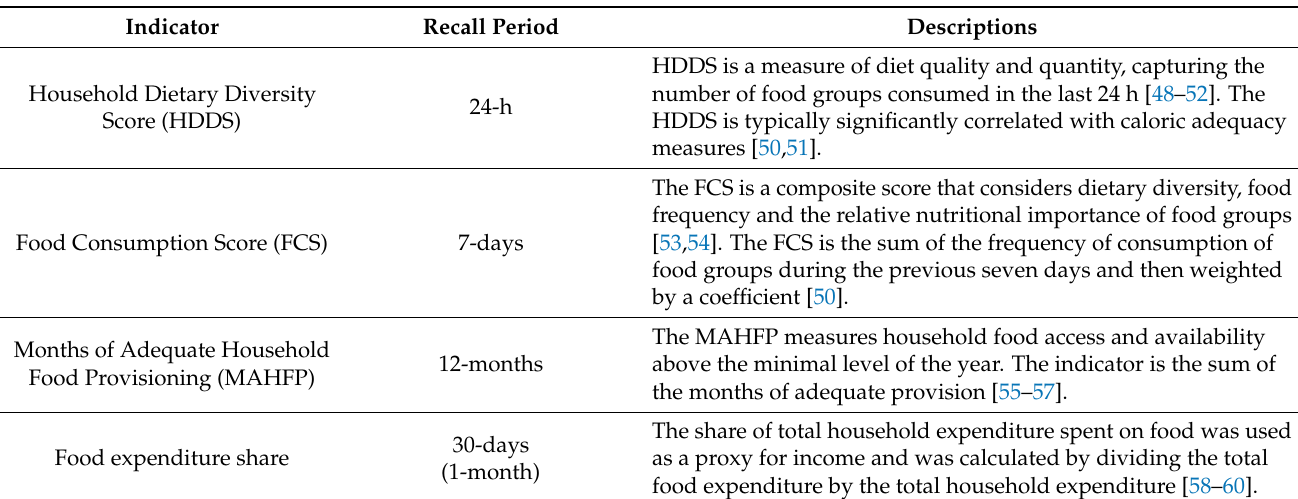
Table 4. Food security indicators used in the